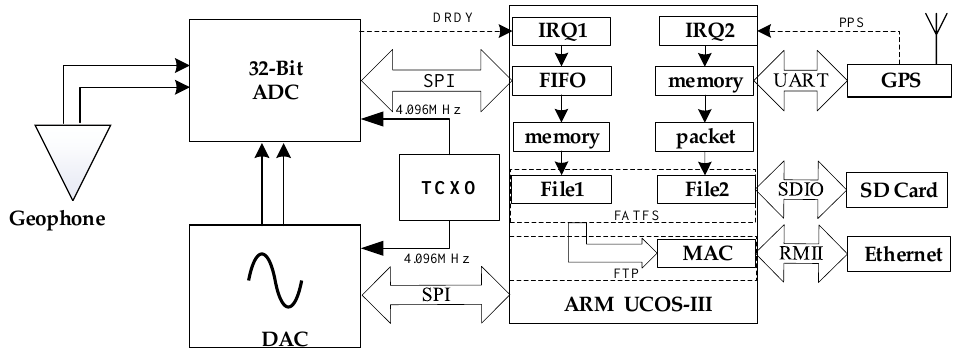
Figure 5. Architecture of the time-synchronization system.